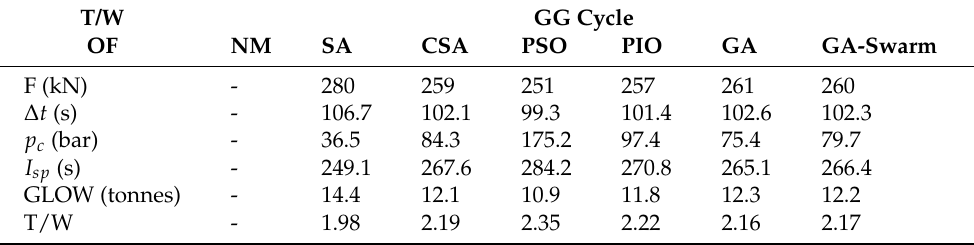
Table 10. GG Cycle: Values of Variables at max T/W for each technique. T/W